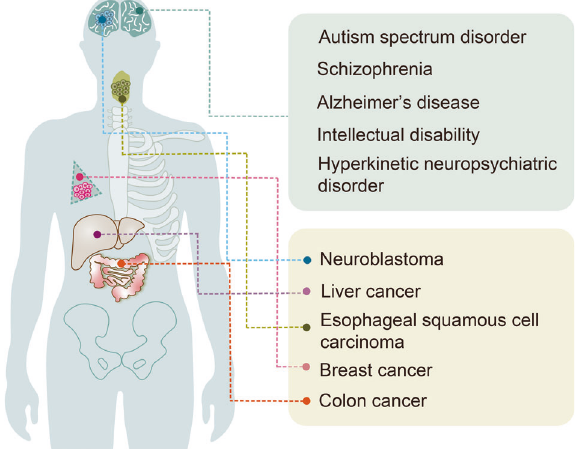
Fig. 1 Schematic diagram of diseases caused by SHANK muta- tions. Mutations of SHANK have been identi fi ed in many human diseases, including neurodevelopmental disorders (highlighted in green box) and cancers (highlighted in yellow box).